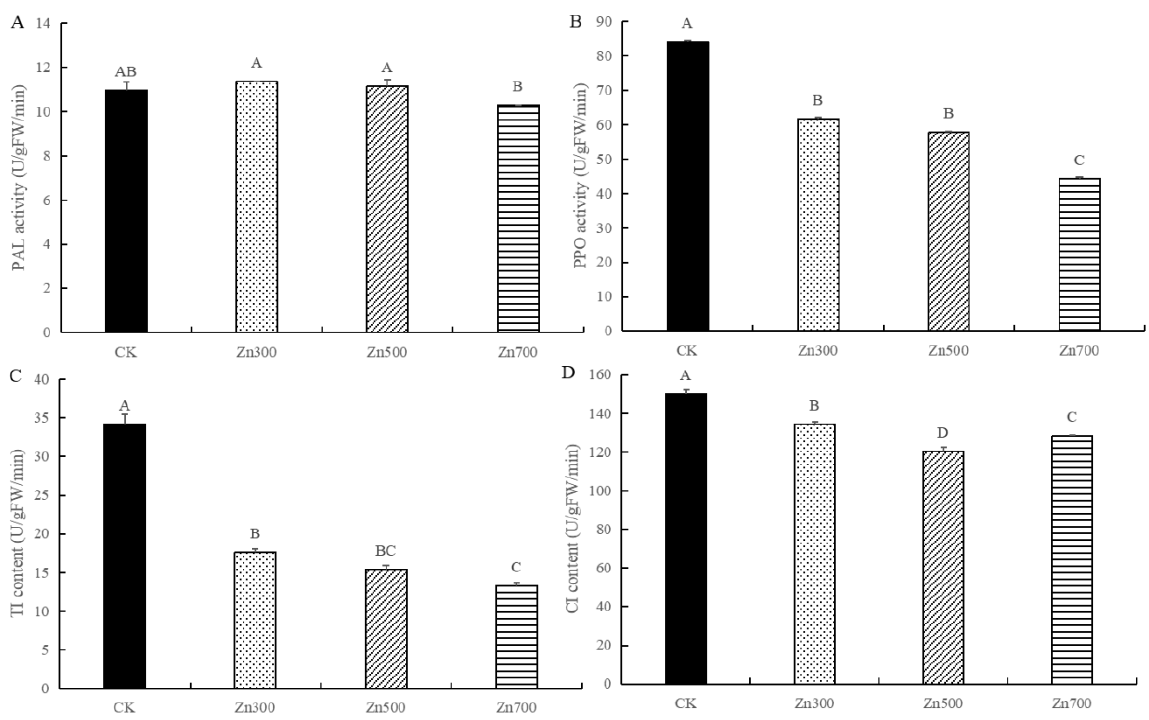
Figure 3. Effects of Zn treatment on the activities of PAL ( A ), PPO ( B ), TI ( C ) and CI ( D ) in P. simonii . The values shown in the figure are the average value ± SD (n = 3). Different letters indicate that there are significant differences among groups (one-way ANOVA, p < 0.05).